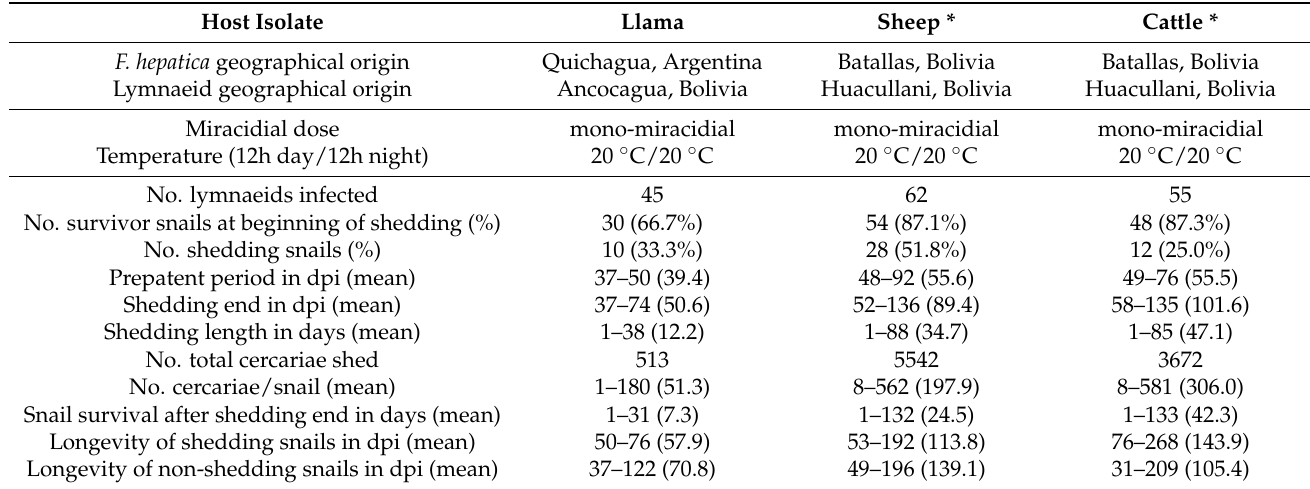
Table 1. Experimental infections of Galba truncatula lymnaeid snails from Ancocagua, Northern Bolivian Altiplano human hyperendemic area, with Fasciola hepatica llama isolate from Quichagua, Argentina, and their comparison with results obtained in the F. hepatica sheep and cattle isolates from the Northern Bolivian Altiplano. Host Isolate Llama Sheep * Cattle